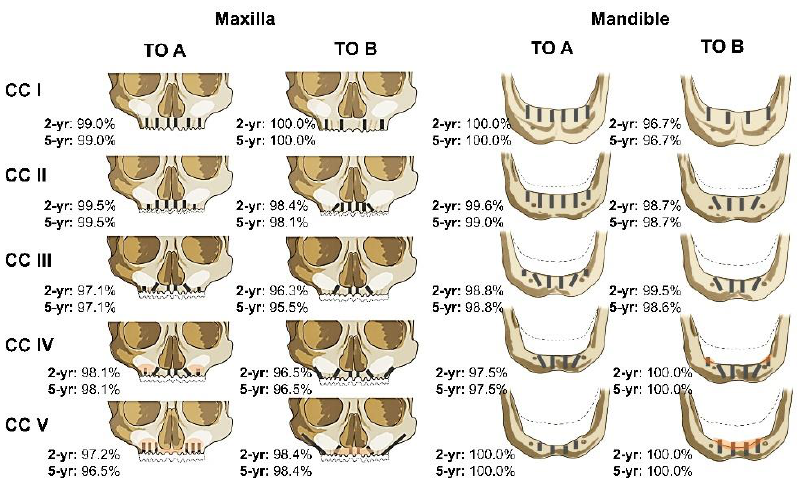
Figure 1. Overview of treatment categories of the applied CDSS with 2-year and 5-year cumulative survival rates (2-yr and 5-yr, respectively). Anatomic categories defining the level of atrophy (CCs) were based on the alveolar dimensions. The CDSS defines three treatment options (TOs), i.e., therapeutic implant configurations, per maxillary and mandibular CC. Only the fixed options, TO A and TO B, are shown for simplicity reasons. Orange regions in CC IV and CC V depict regions with bone augmentation.